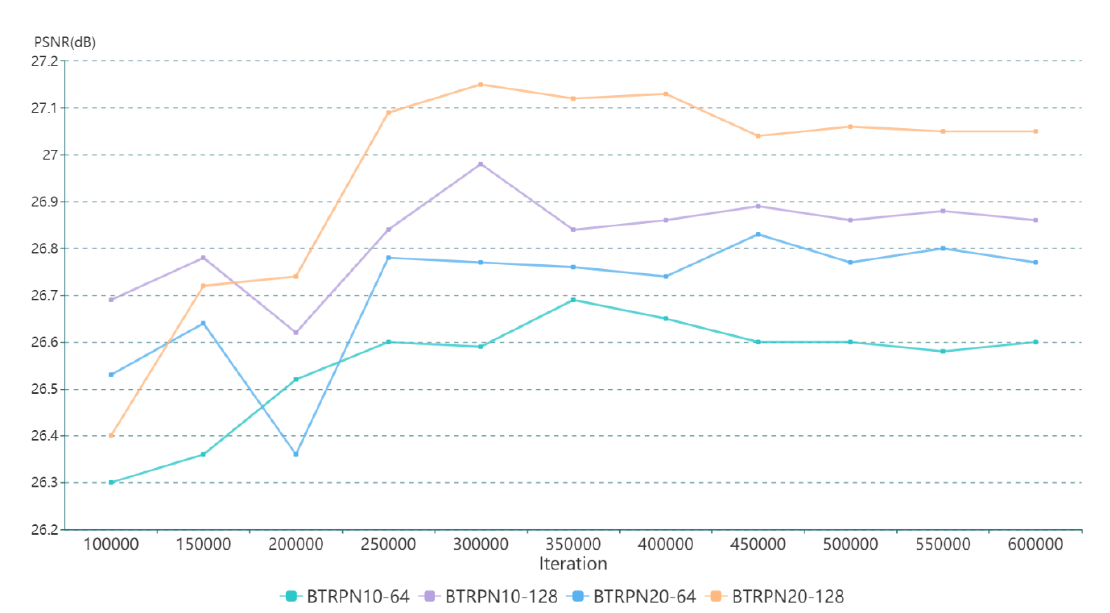
Figure 8. The convergence of different models.